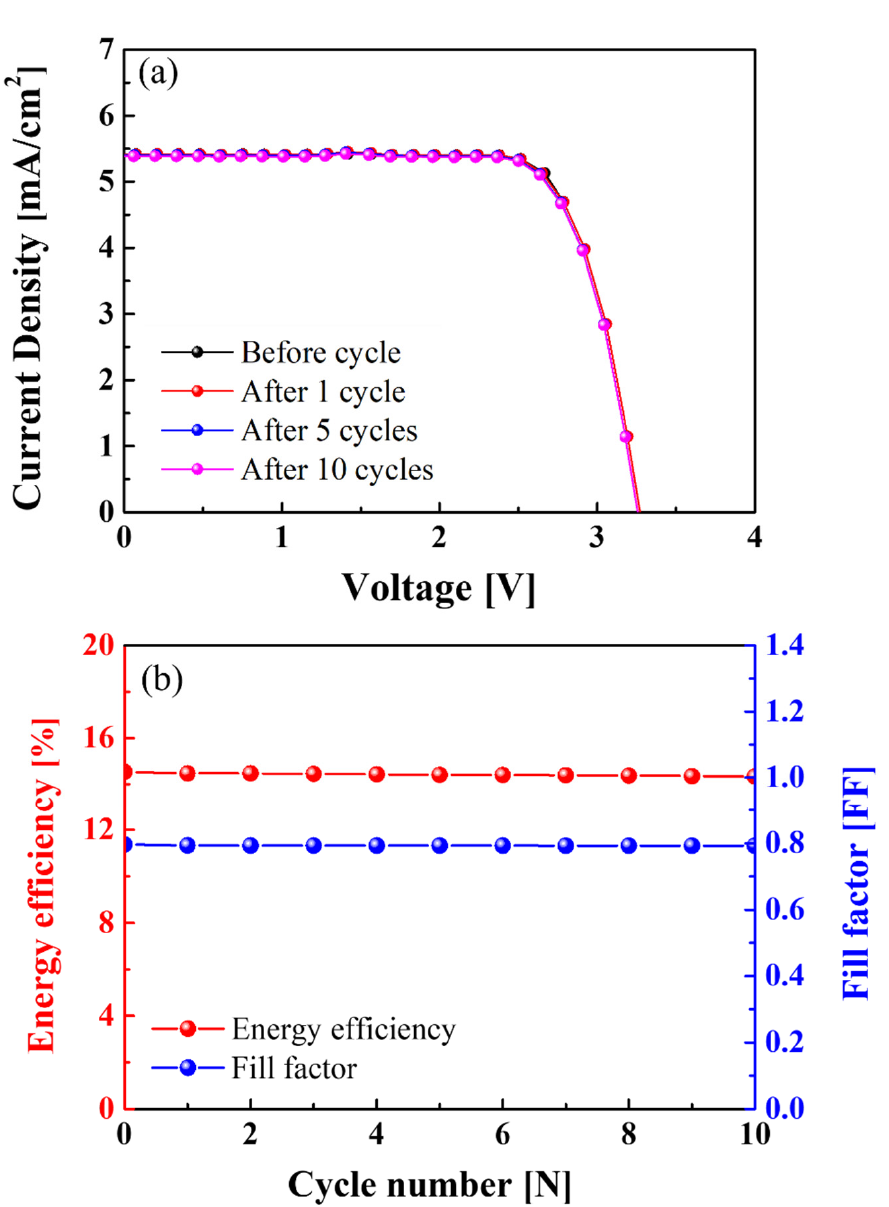
Figure 8. ( a ) J-V curve and ( b ) energy efficiency and fill factor (FF) of Si solar cells connected to the NCM-LTO full-cell before and after 10 cycles.